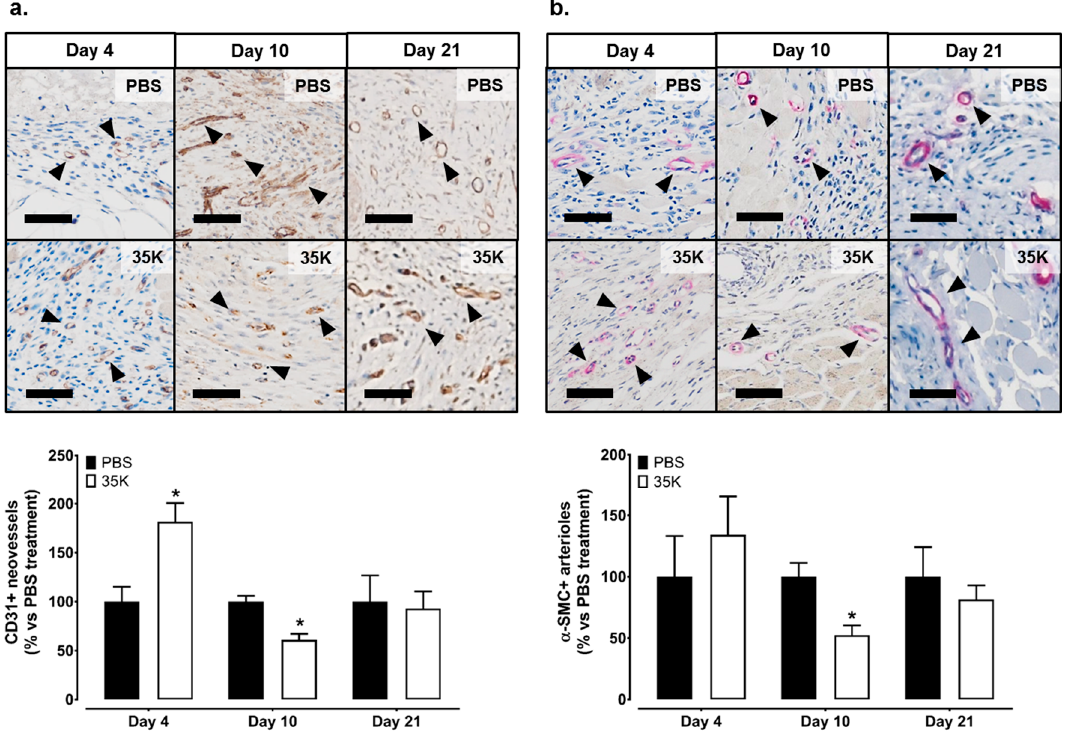
Figure 2. Inhibition of CC-chemokines by 35K increases neovessel formation in the early stages of wound repair but decreases neovessels in later stages. Immunocytochemistry was used to detect the presence of neovessels and arterioles. Photomicrographs represent wounds stained for ( a ) CD31+ neovessels (stained brown, noted by black arrows) and ( b ) α -SMC+ arterioles (stained pink, noted by black arrows). Three tiled images were taken per wound ( n = 7–12/treatment). Scale bars represent 50 μ m. Data is represented as mean ± SEM. Statistical analysis was performed by an unpaired two-tailed t -test. * p < 0.05 compared to PBS treated wounds.